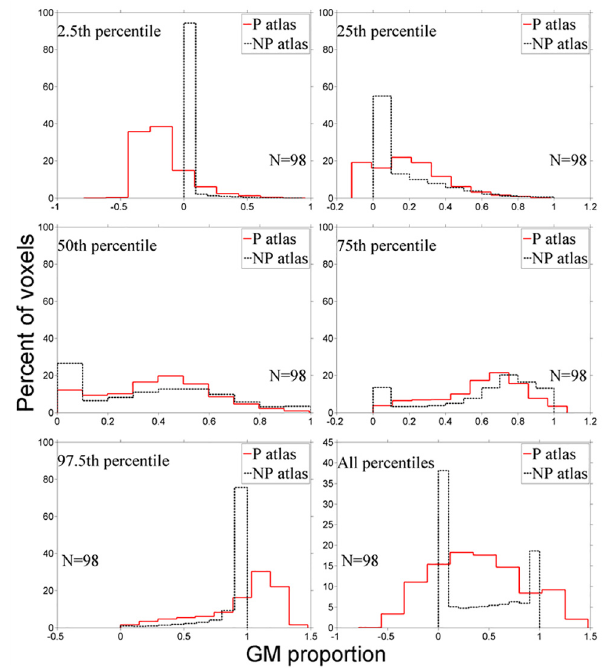
Fig 9. Histograms of the parametric (mean ± SD; P) and nonparametric (order-based; NP) grey matter (GM) atlas percentile